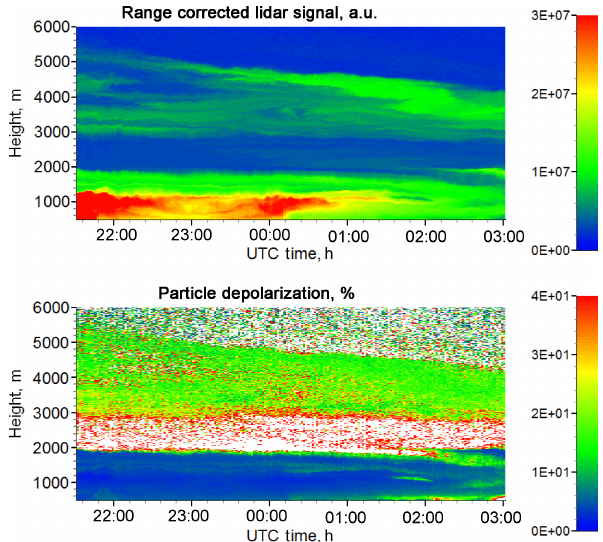
Figure 6. Range-corrected lidar signal at 1064nm and the particle depolarization ratio at 532nm for the night of 13–14 June 2018.